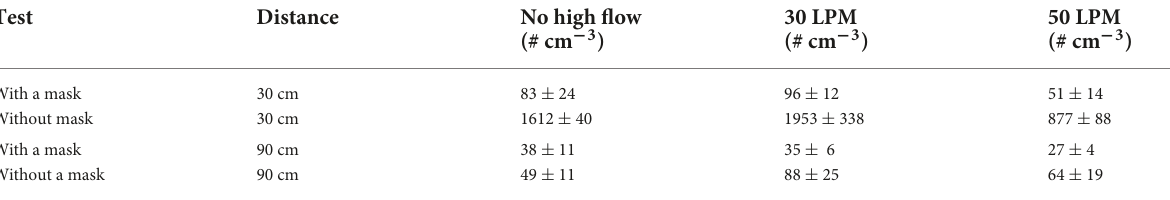
TABLE 1 Ten-minute averaged PNC during each high flow rate; mean and standard deviations over the three events. Test